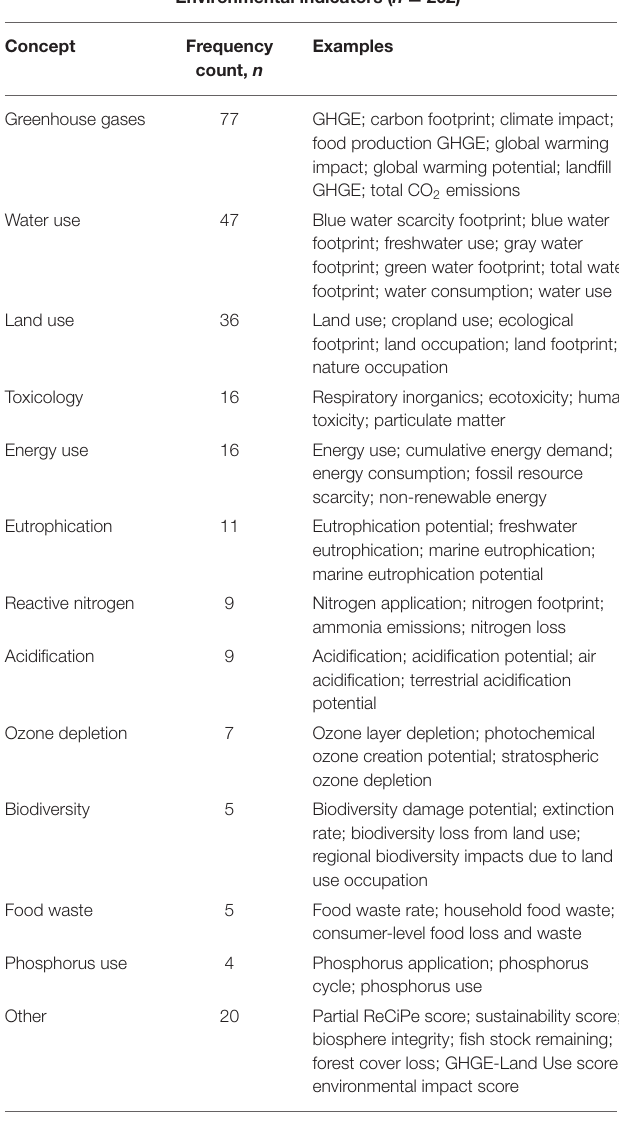
TABLE 2 | Environmental indicators by concept measured and frequency of use in the scoping